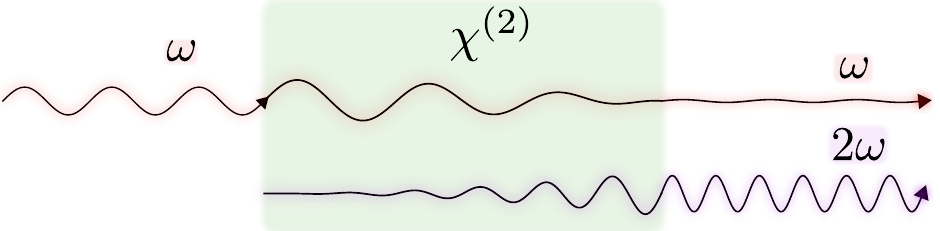
Figure 1. Schematic representation of the second-harmonic generation process, where the electro- magnetic radiation is converted from the frequency ω to its double frequency 2 ω